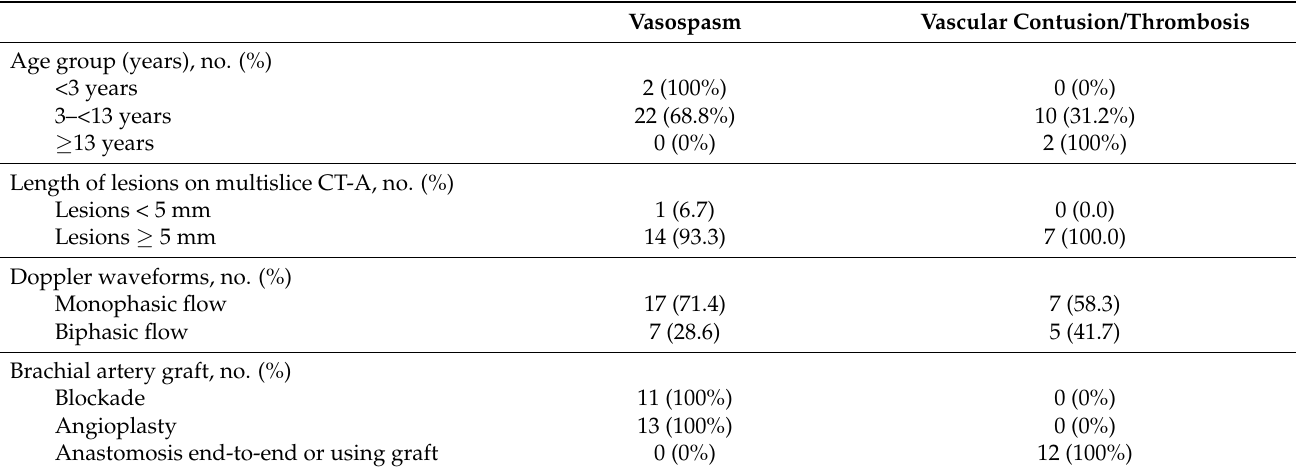
Table 4. Association of intraoperative vascular injury with age group, lesions on multislice CT, preoperative Doppler spectrum analysis and brachial artery graft in pediatric patients undergoing surgical treatment. Vasospasm Vascular Contusion/Thrombosis